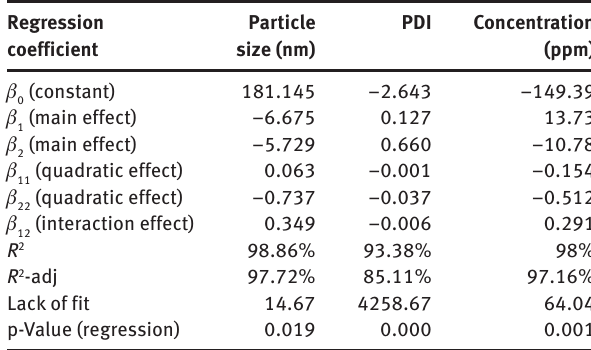
Table 2: Regression coefficients, R 2 , R 2 -adj, and probability values for the fitted models.